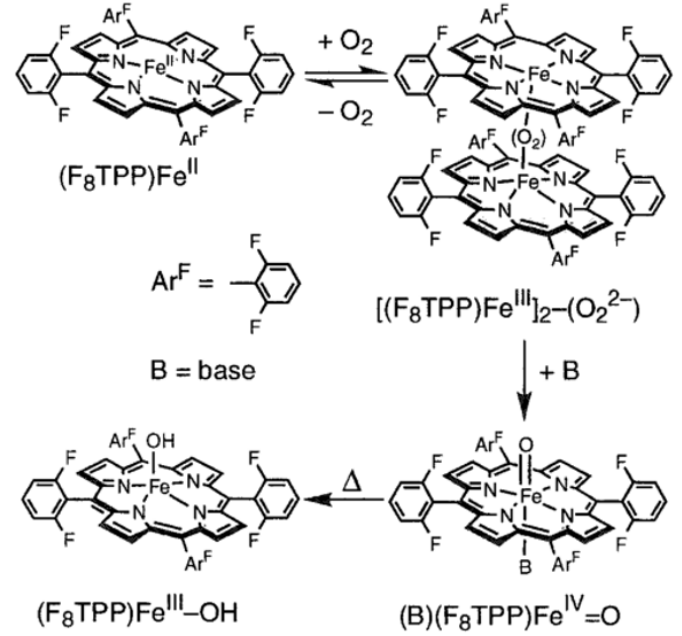
Figure 8. Formation of peroxo-bridged dinuclear complex {[(F 8 TPP)Fe III ] 2 (O 22 − )} in noncoordinating solvents and its stepwise transformation to a high-spin iron(III)-hydroxide species, [(F 8 TPP)Fe III (OH)]. Reprinted with permission from Ref. [100]. Copyright 2001, American Chemical Society.